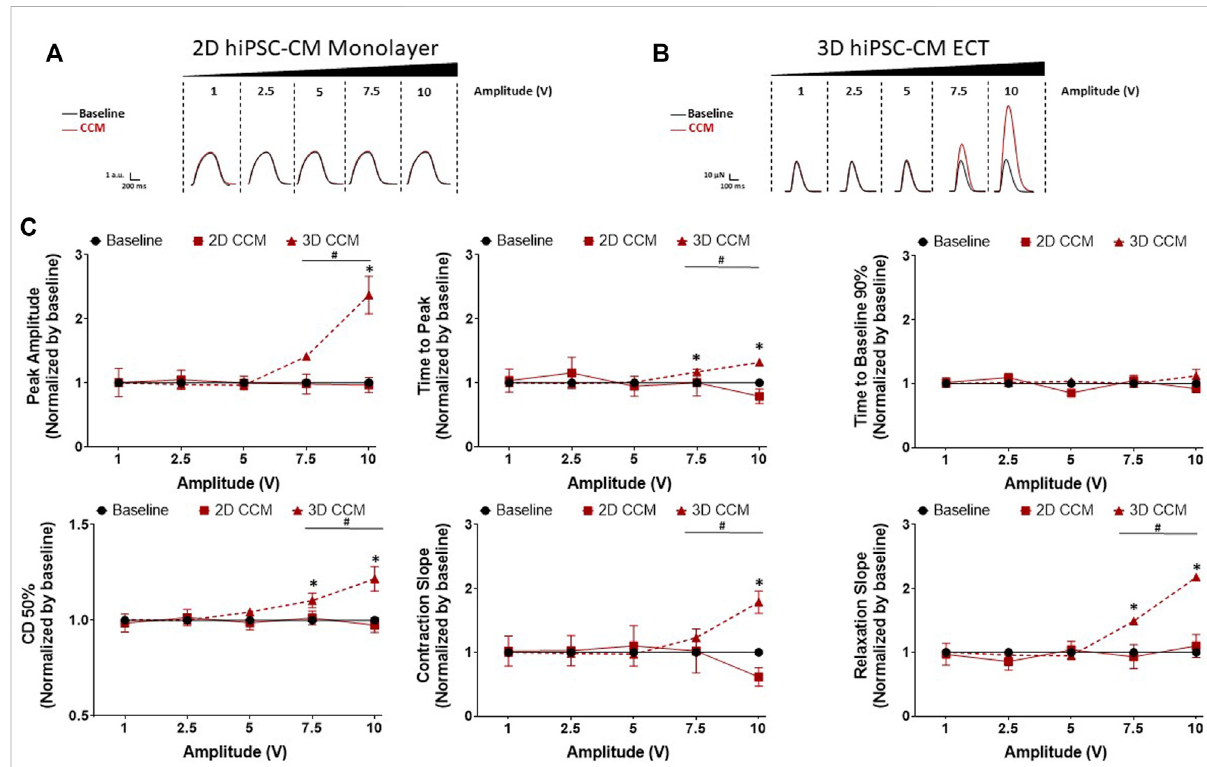
FIGURE 6 Effect of CCM pulse amplitude on 2D and 3D hiPSC-CM contractile properties (A) Representative contraction traces for baseline (i.e., fi eld stimulation pacing, 1 Hz). and CCM for 2D hiPSC-CMs monolayer and (B) 3D ECTs (C) Summary data graphs. Data are mean ± SEM. n = 3 – 6 per group. * p < 0.05 (3D vs. BL), # p < 0.05 (3D vs. 3D), + p < 0.05 (2D vs.